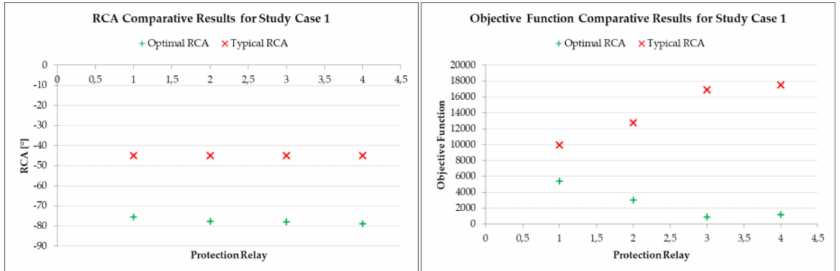
Figure 11. Comparative results for the evaluation of polarization on the directional ground overcurrent element (ANSI 67N) in the protection relays of Study Case 1—negative sequence polarization.